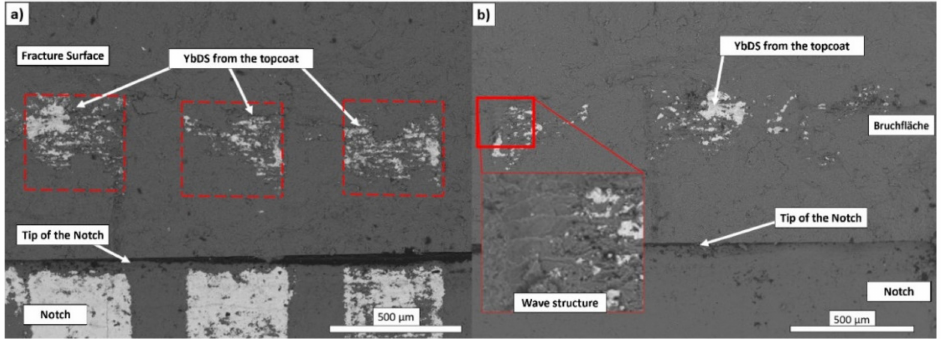
Figure 11. Fractured surfaces of the layer side ( a ) and the substrate side ( b ) of a completely delami- nated, ST3-structured sample with red marked positions of the basin-and wave-like